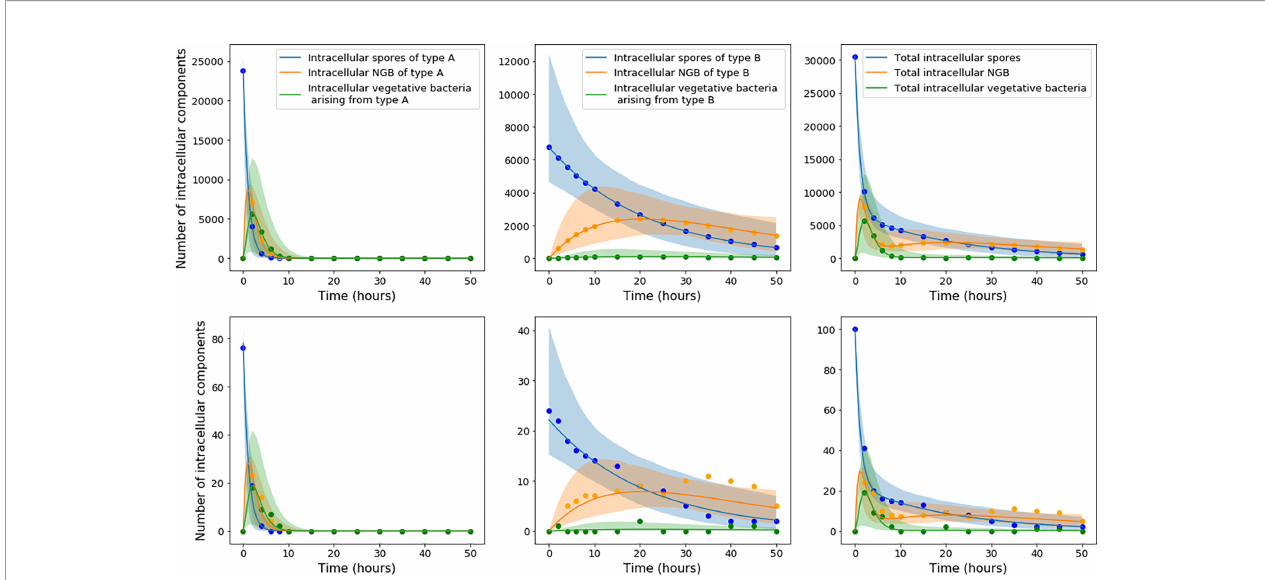
FIGURE 5 | The top row of plots corresponds to a population of S 0 = 30500 infected cells, each containing a single spore at time 0, whereas the bottom row ( t ; g = g A ) , type A newly germinated bacteria, e S 0 p 1 ( t ; g = g A ), corresponds to an initial condition of S 0 = 100. Left: The mean number of type A spores, e S 0 p 1 S NGB i p i ( t ; g = g A ), arising from the type A spores in the infected macrophages. Centre: The analogous functions for the and vegetative bacteria, e S 0 B V ( t ; g A ) = e S 0 o ∞ i =1 populations arising from the initial spores with germination rate g B . Right: The overall mean number of spores, S 0 S ( t ), newly germinated bacteria, S 0 B NGB ( t ), and vegetative bacteria, S 0 B n ( t ), obtained by adding together the populations for each type of spore. The solid lines indicate the means for the estimated parameter values in Table 5 , while the shaded regions indicate the pointwise 95% credible intervals for these means, when the uncertainty in the parameter values from the posterior distributions is taken into account. The equations used to compute these curves were Eqs. (5), (6), (11), (12), (41), and (42). The dots show values for the size of the different populations over time from a single stochastic simulation beginning with S 0 spores.